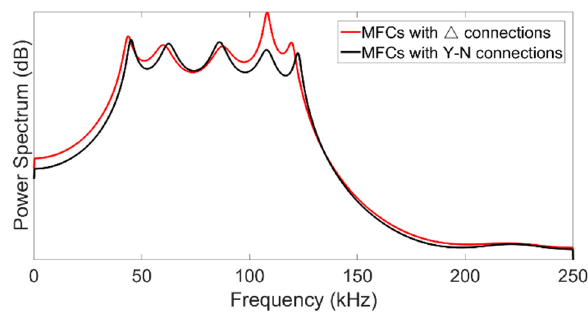
Figure 14. Power spectra of partial discharges in MFCs with different connections.